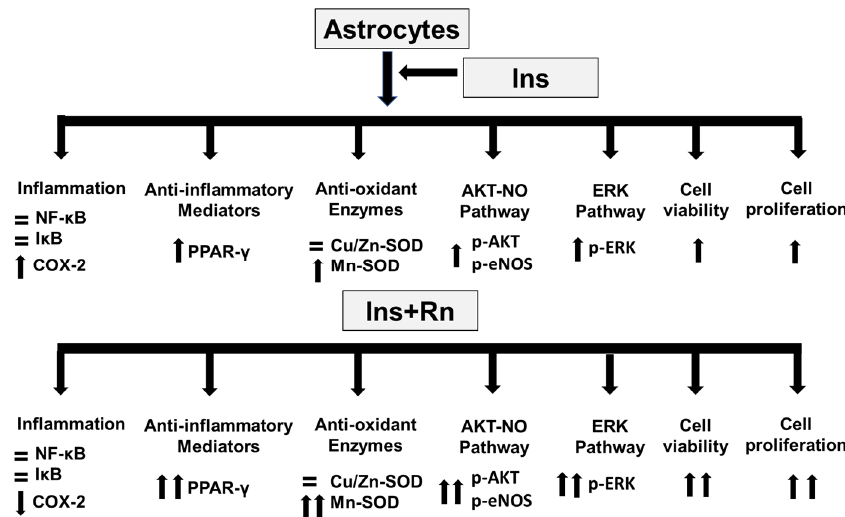
Figure 10. Changes after Ins and Rn addition to astrocytes in primary culture. Rn facilitates the effects of insulin, increasing cell viability and proliferation, along with the expression of anti-inflammatory mediators, such as PPAR- γ , and inhibiting that of pro-inflammatory mediators, such as COX-2. Furthermore, Rn potentiated the effect of insulin on the expression of an antioxidant enzyme (Mn-SOD), the components of the AKT-eNOS pathway, and the ERK signaling pathway.